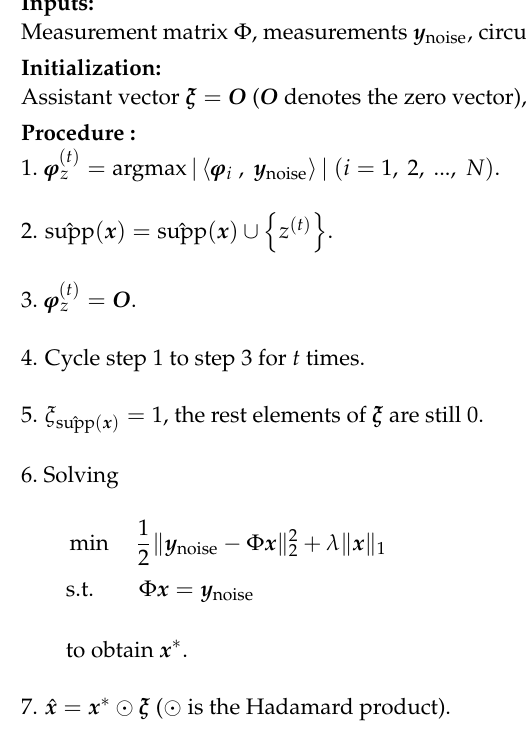
Algorithm 1. The supp-BPDN algorithm